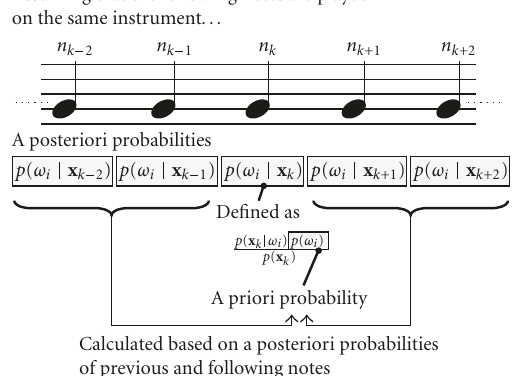
Figure 3: Key idea for using musical context. To calculate a poste- riori probability of note n k , a posteriori probabilities of temporally neighboring notes of n k are